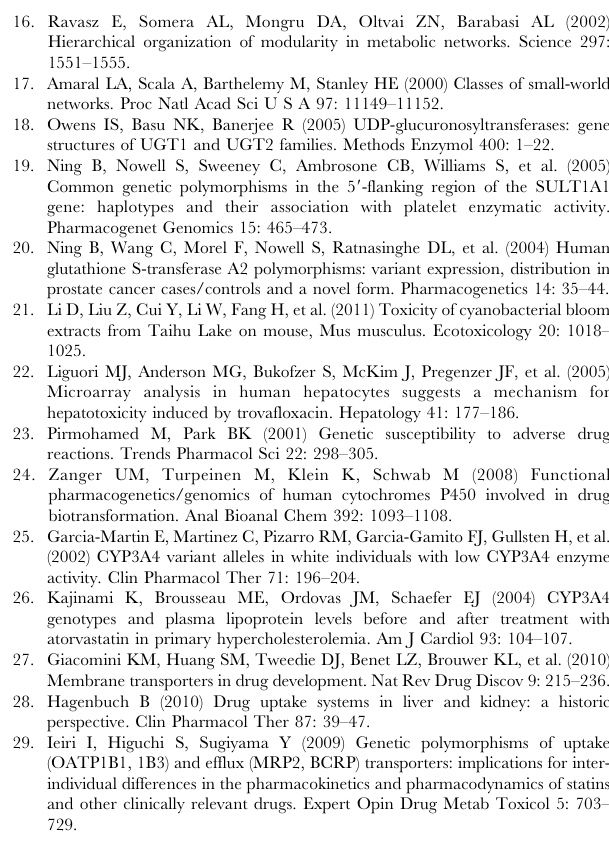
Table S1 The inter-individual variability of 374 DMETs among 427 human liver